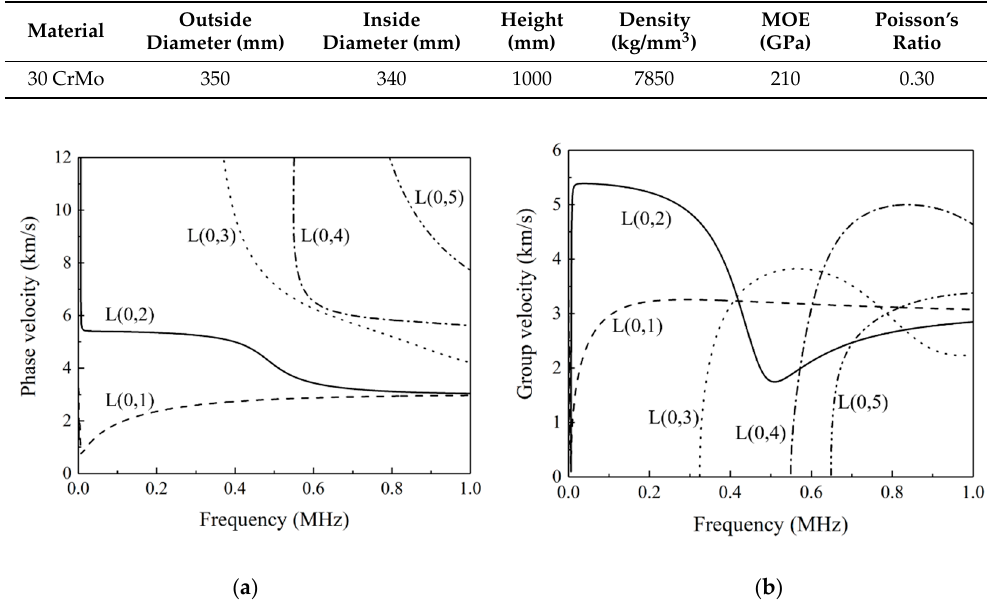
Figure 6. Dispersion curves in 5 mm thick pressure vessel: ( a ) dispersion curve of phase velocity; ( b ) dispersion curve of group velocity.